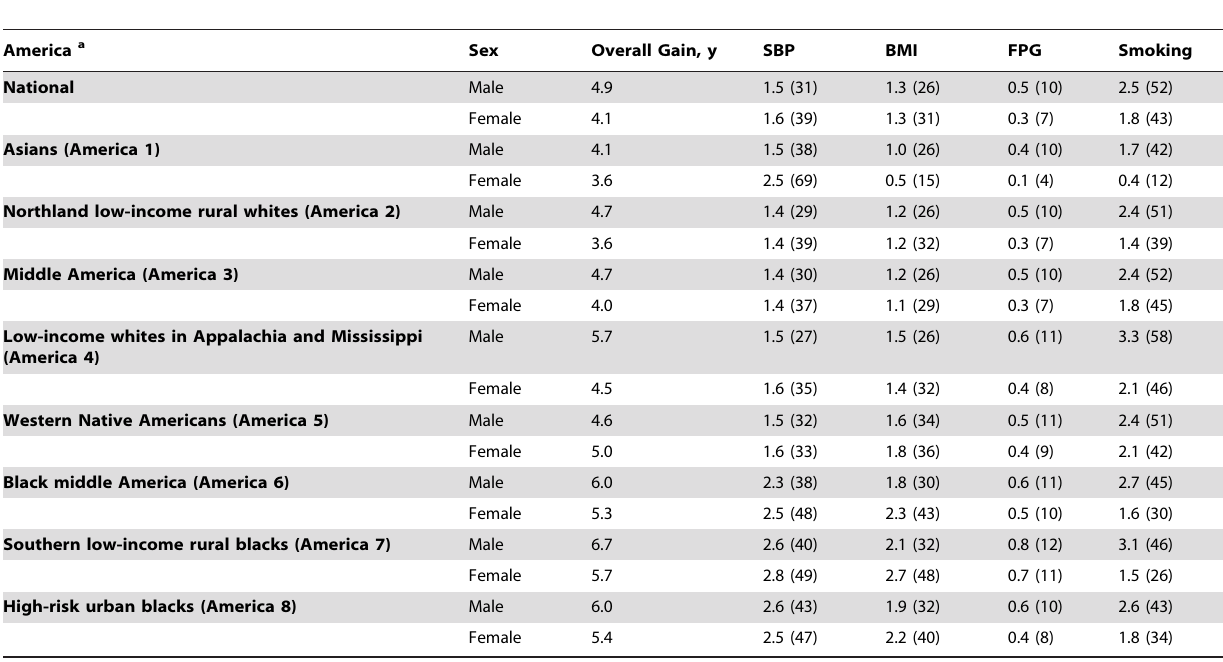
Table 4. Life expectancy gains (in years) expected by reducing individual risk factors to their optimal distributions.